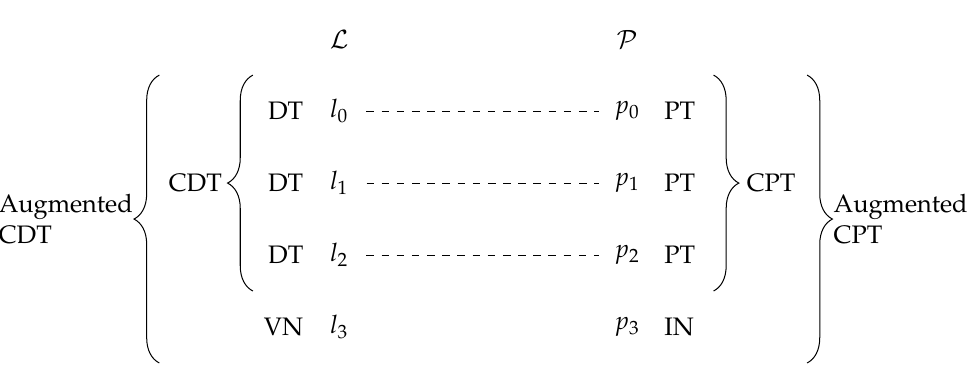
Figure 1. Augmented collectives of digital and physical twins.